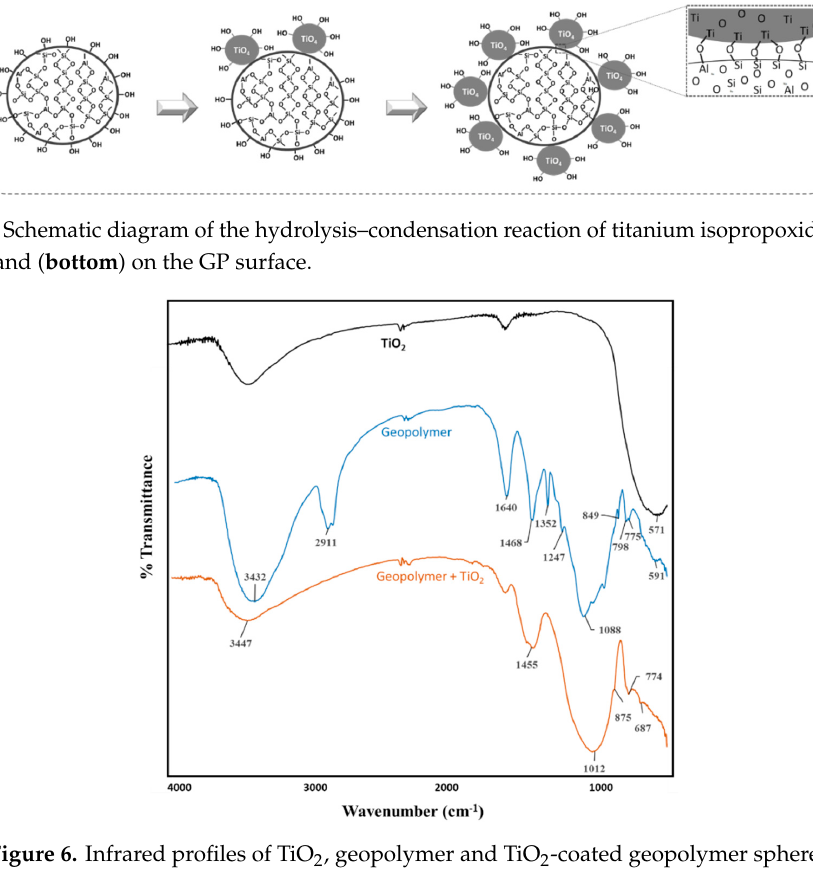
Figure 6. Infrared profiles of TiO 2 , geopolymer and TiO 2 -coated geopolymer sphere.